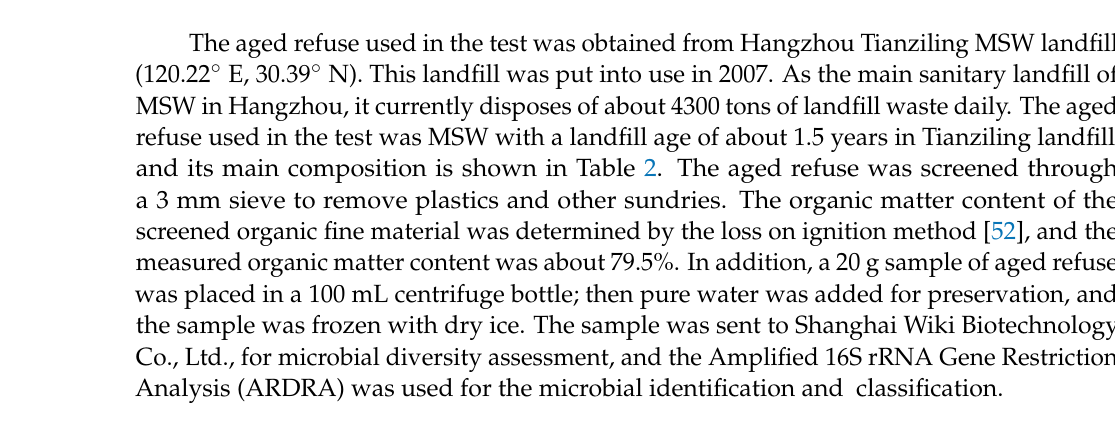
Table 2. Composition of the aged